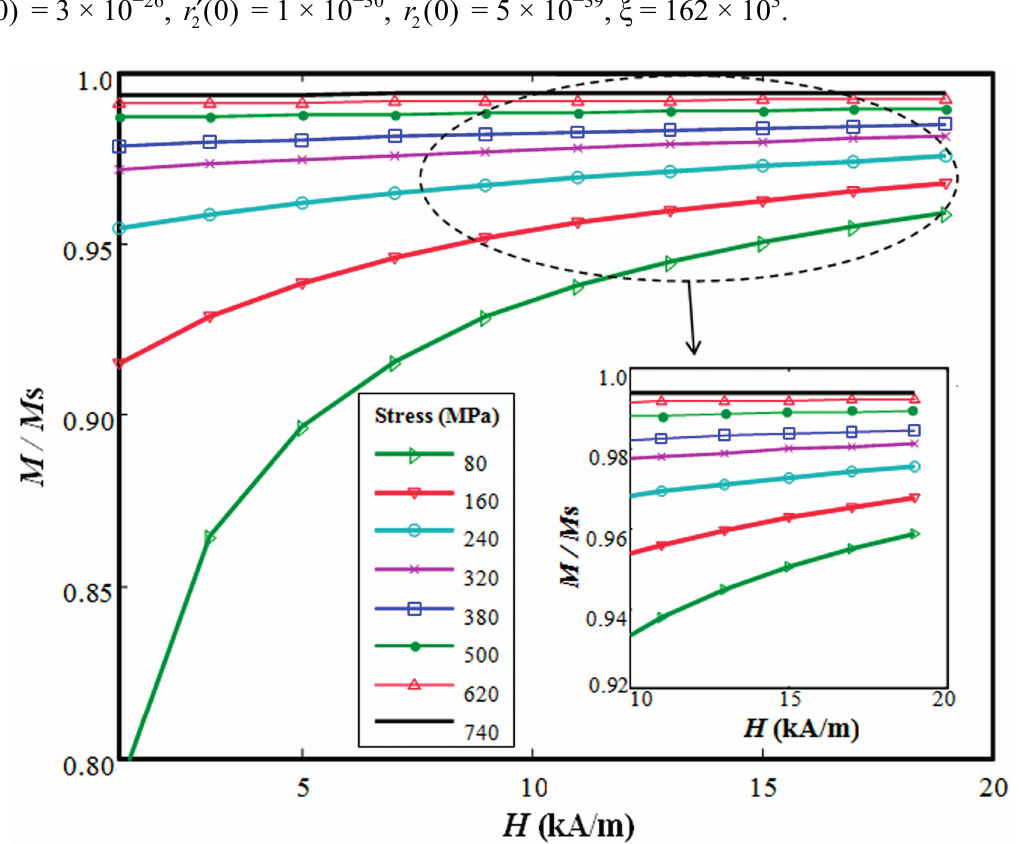
Figure 2. The simulated hysteresis loop of the descending part in the first quadrant under different stress levels obtained from solution of the model equations with M a = 1000 A/m, k = 1300 A/m, α = 1.0 × 10 − 3 , c = 0.1, E = 2.0 × 10 11 ,